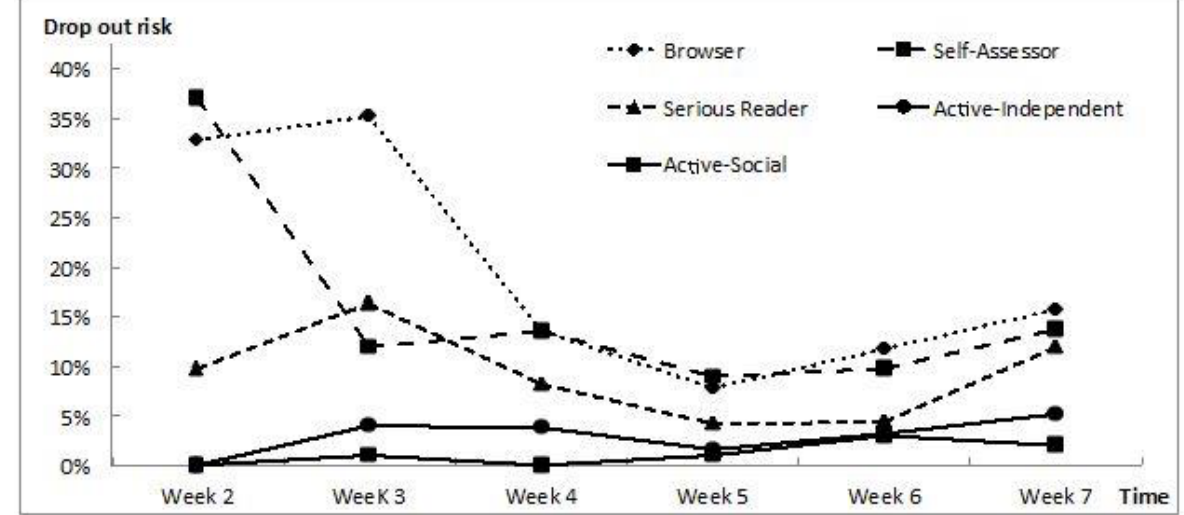
Figure 3. Time vs. dropout risk proportion for each of the participant profiles. A log-rank test used to compare several survival curves that take into account all the follow-up time (Alberti, Timsit, & Chevret, 2005) shows significant differences between the different engagement profiles (χ 2 (4) = 355.71, p <